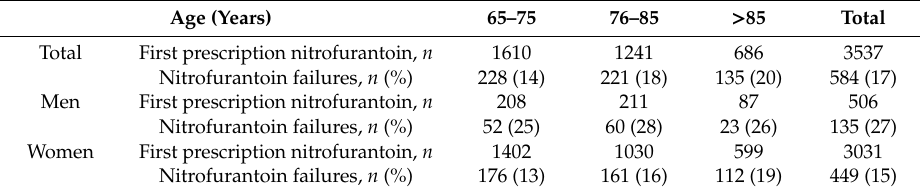
Table 1. First nitrofurantoin prescription in 2015 and failure prevalence for men and women.